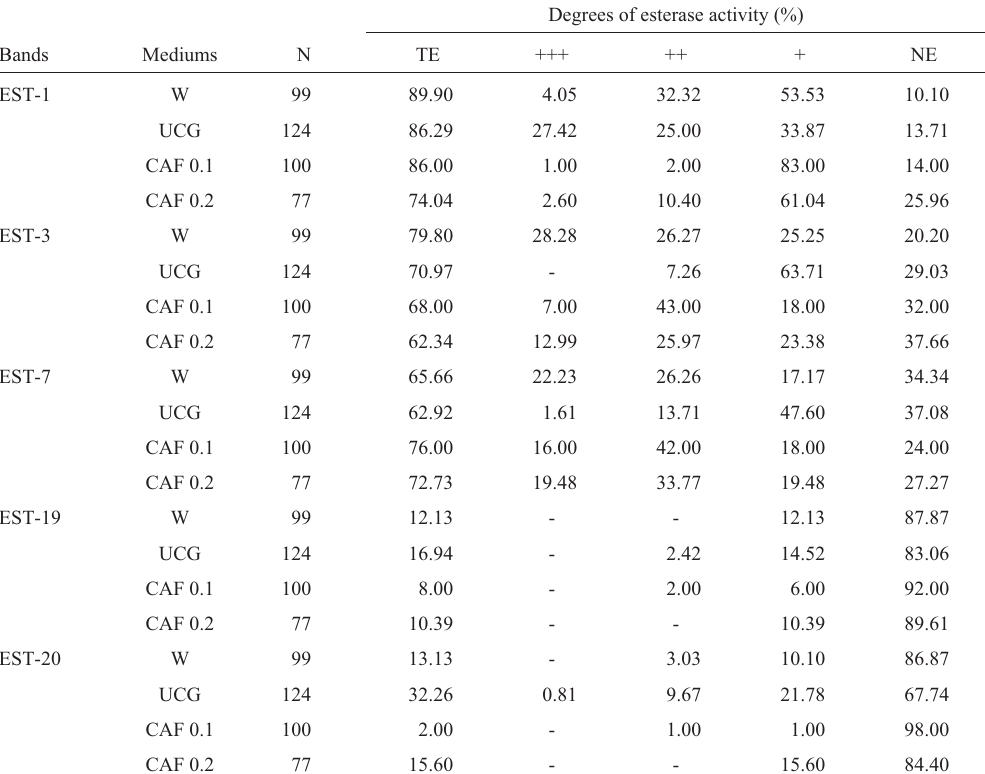
degree of activity (+), from 220 to 246. The absence of the band in the gel was set at about 250 on the grayscale. The scale values absent in the class intervals were not found in the measurements. The profile graphs corresponding to the band patterns are shown in Figures 1 and 2. The horizontal axis of the profile graph represents the points along the line segment (horizontal sequence of bands in the gel) and the Table 5 - Percentage of larvae expressing the esterase bands (TE), in the different degrees (+++, ++, +) or not expressing them (NE), in the treatments with caffeine (CAF) at 0.1 and 0.2 mg/mL, used coffee grounds (UCG) at 25 mg/mL and water (W) for control. N = number of larvae analyzed for the band activity